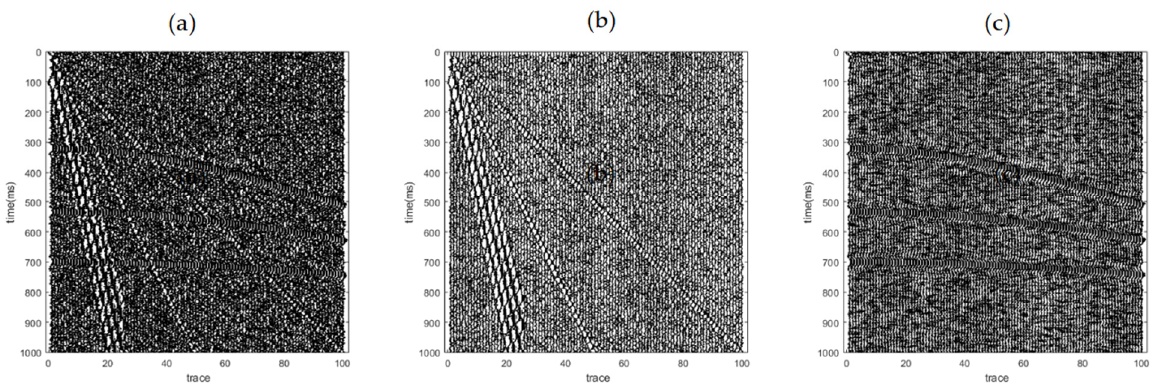
Figure 4. The processing results of the synthetic seismic data by the proposed method. ( a ) The original synthetic seismic data. ( b ) The removed noise. ( c ) The seismic data after the denoising.